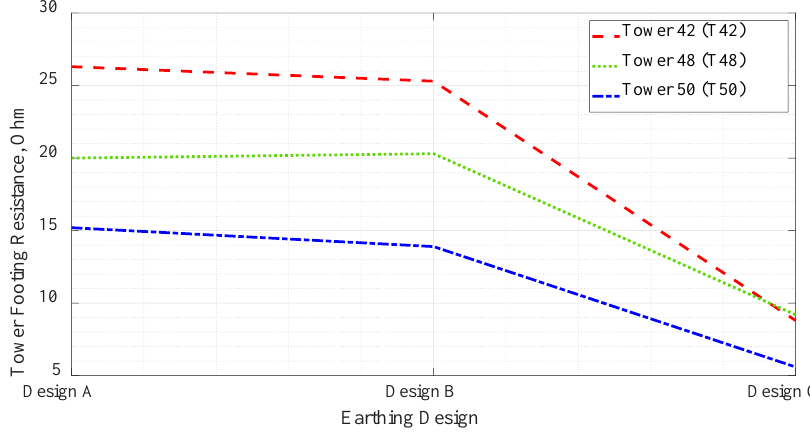
Figure 11. Influence of design arrangements on tower footing resistance in a 2-layer, 3-layer and 4-layer soil in Towers T42, T48 and T50, respectively. Table 5. Tower footing resistance analysis of different design arrangements.